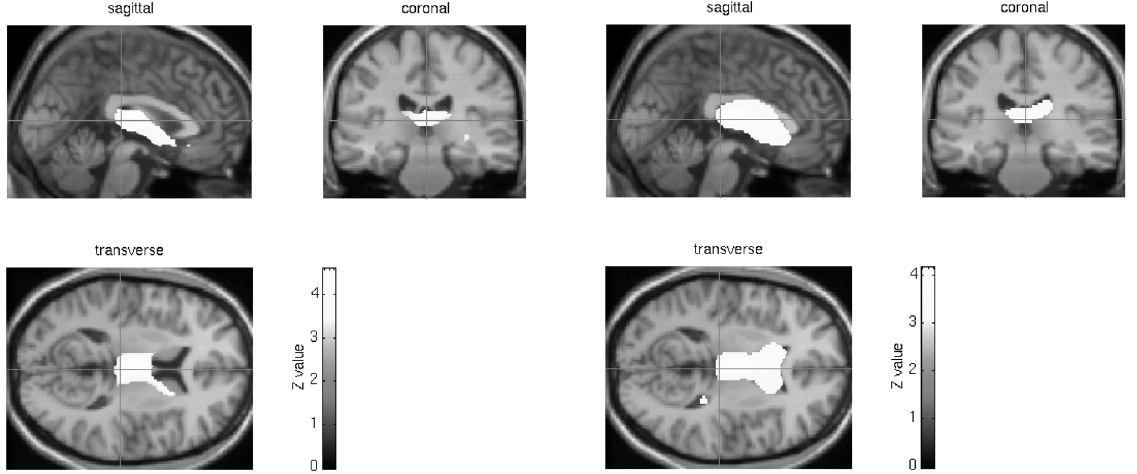
Fig. 4. SPM results comparing the patient group with control subjects; Fig. 4(a)(left): whole brain normalisation, Fig. 4(b)(right): cerebellar normalisation. The figures show selected orthogonal slices through the corresponding statistical parametric map superimposed on a standard T1 weighted MR image, which is displayed in Talairach